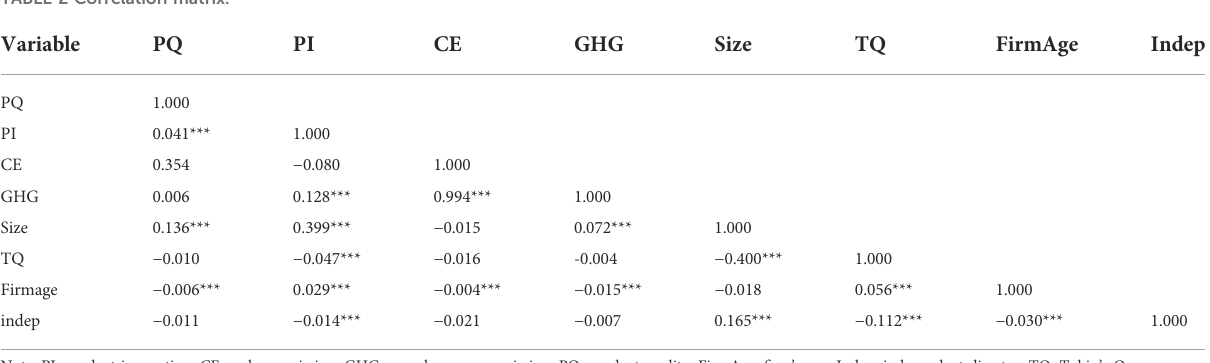
TABLE 2 Correlation matrix.